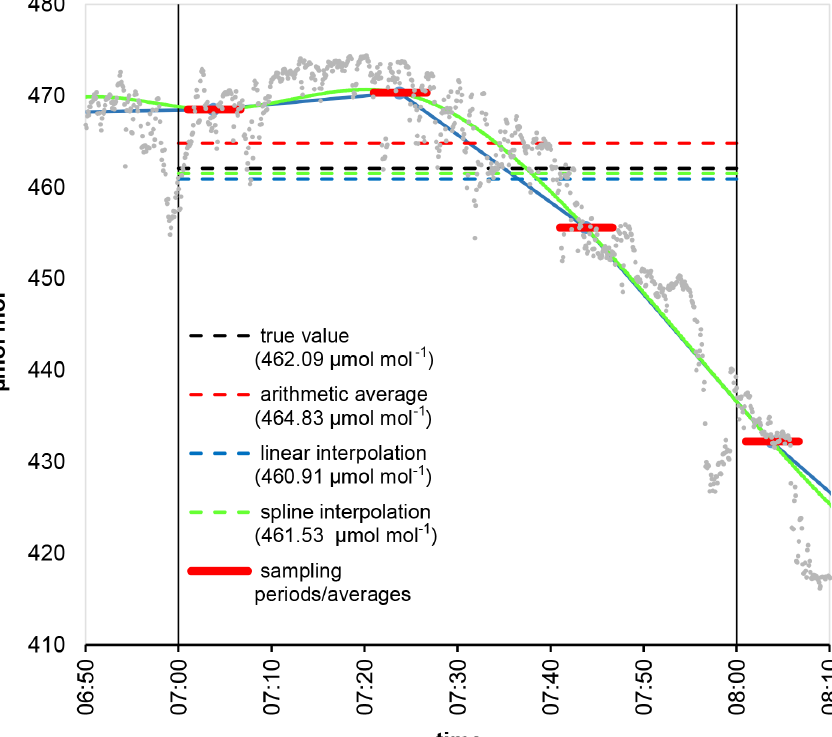
Figure 3. Difference between the hourly averages estimated by arithmetic averaging, linear interpolation, and spline interpolation compared to the true value in a typical summer morning hour (2 May 2018, 07:00–08:00LST (local standard time, UTC+1). Gray dots are the mea- surement data with 5s temporal resolution, while the thick red lines give the sampling periods and their average concentrations supposing three intakes and 400s sampling time (60s flushing + 340s signal integration at each intake). The height of the planetary boundary layer changed from 399 to 555m from 07:00 to